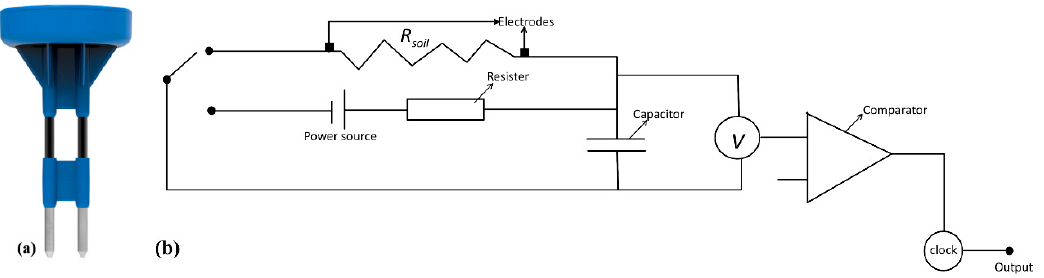
Figure 1. ( a ) The Sensoterra B.V. soil moisture sensor and ( b ) the circuit diagram of the sensor with resister, capacitor, power source, clock, and comparator.